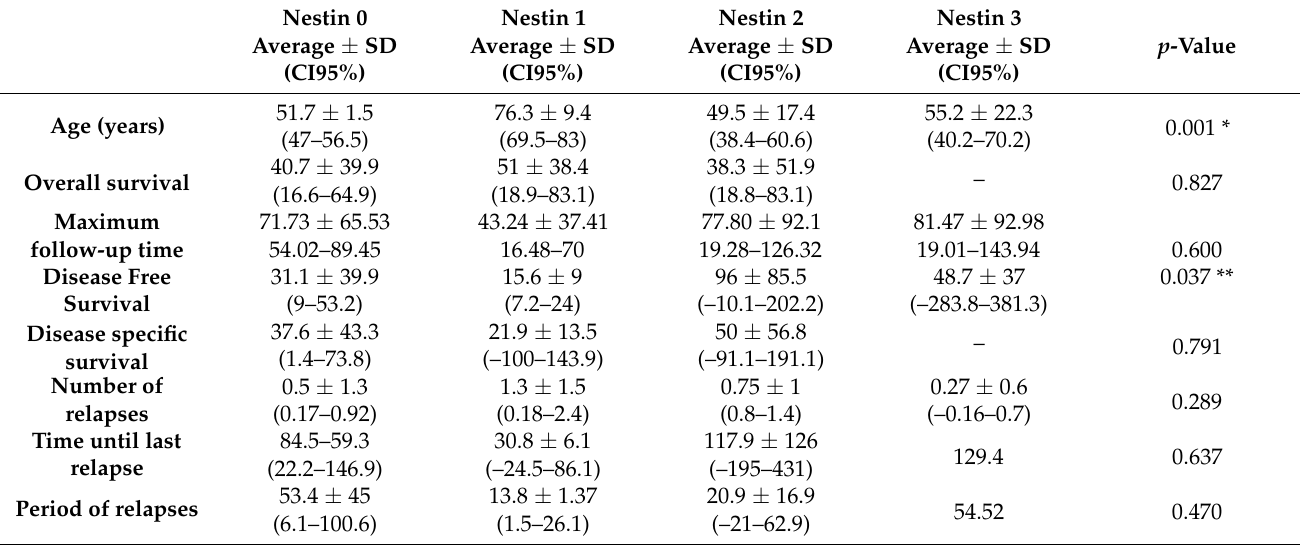
Table 2. Distribution of quantitative variables. CI: confidence